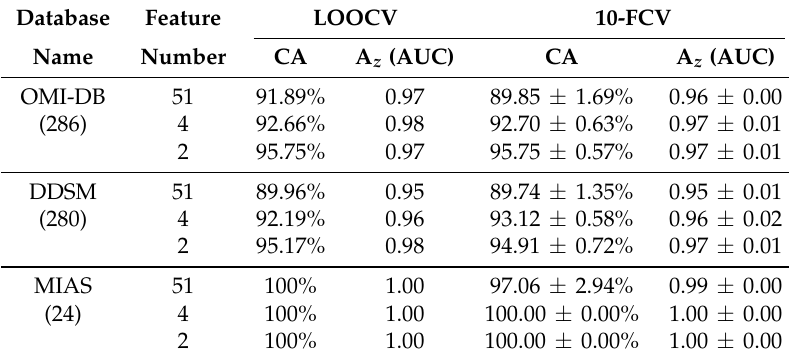
Table 5. Classification accuracy using LOOCV and 10-fold CV applying all 51 and the 2 most salient features from digital mammogram, and 4 most salient features from the digitized mammogram using stacked generalization. The images were segmented following the clinical grounding of cluster distribution. Naive Bayes was used as the meta-classifier.